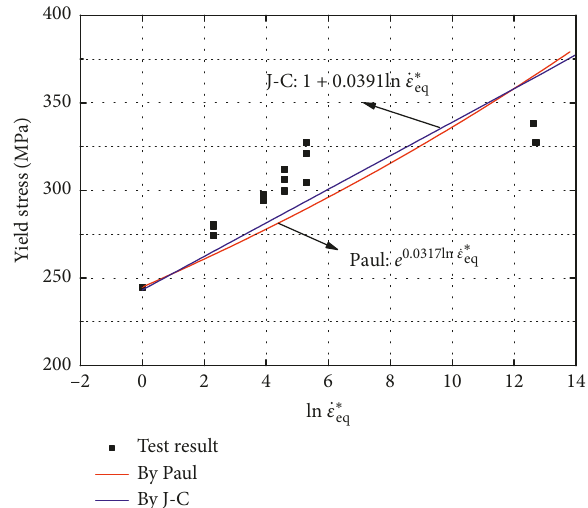
Figure 2: Yield stress at different strain rates. Figure 1: Load-displacement curve of smooth cylindrical specimen